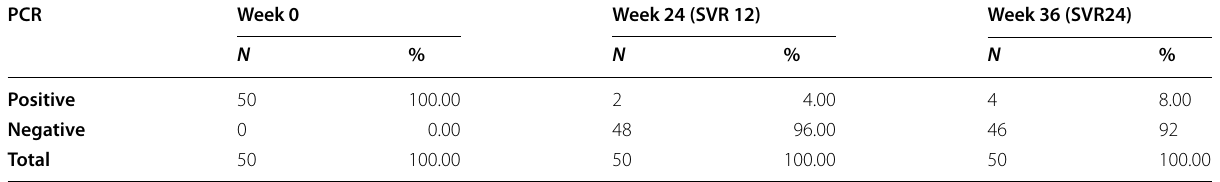
Table 3 HCV PCR of the studied group at weeks 24 and 36 of DAA therapy